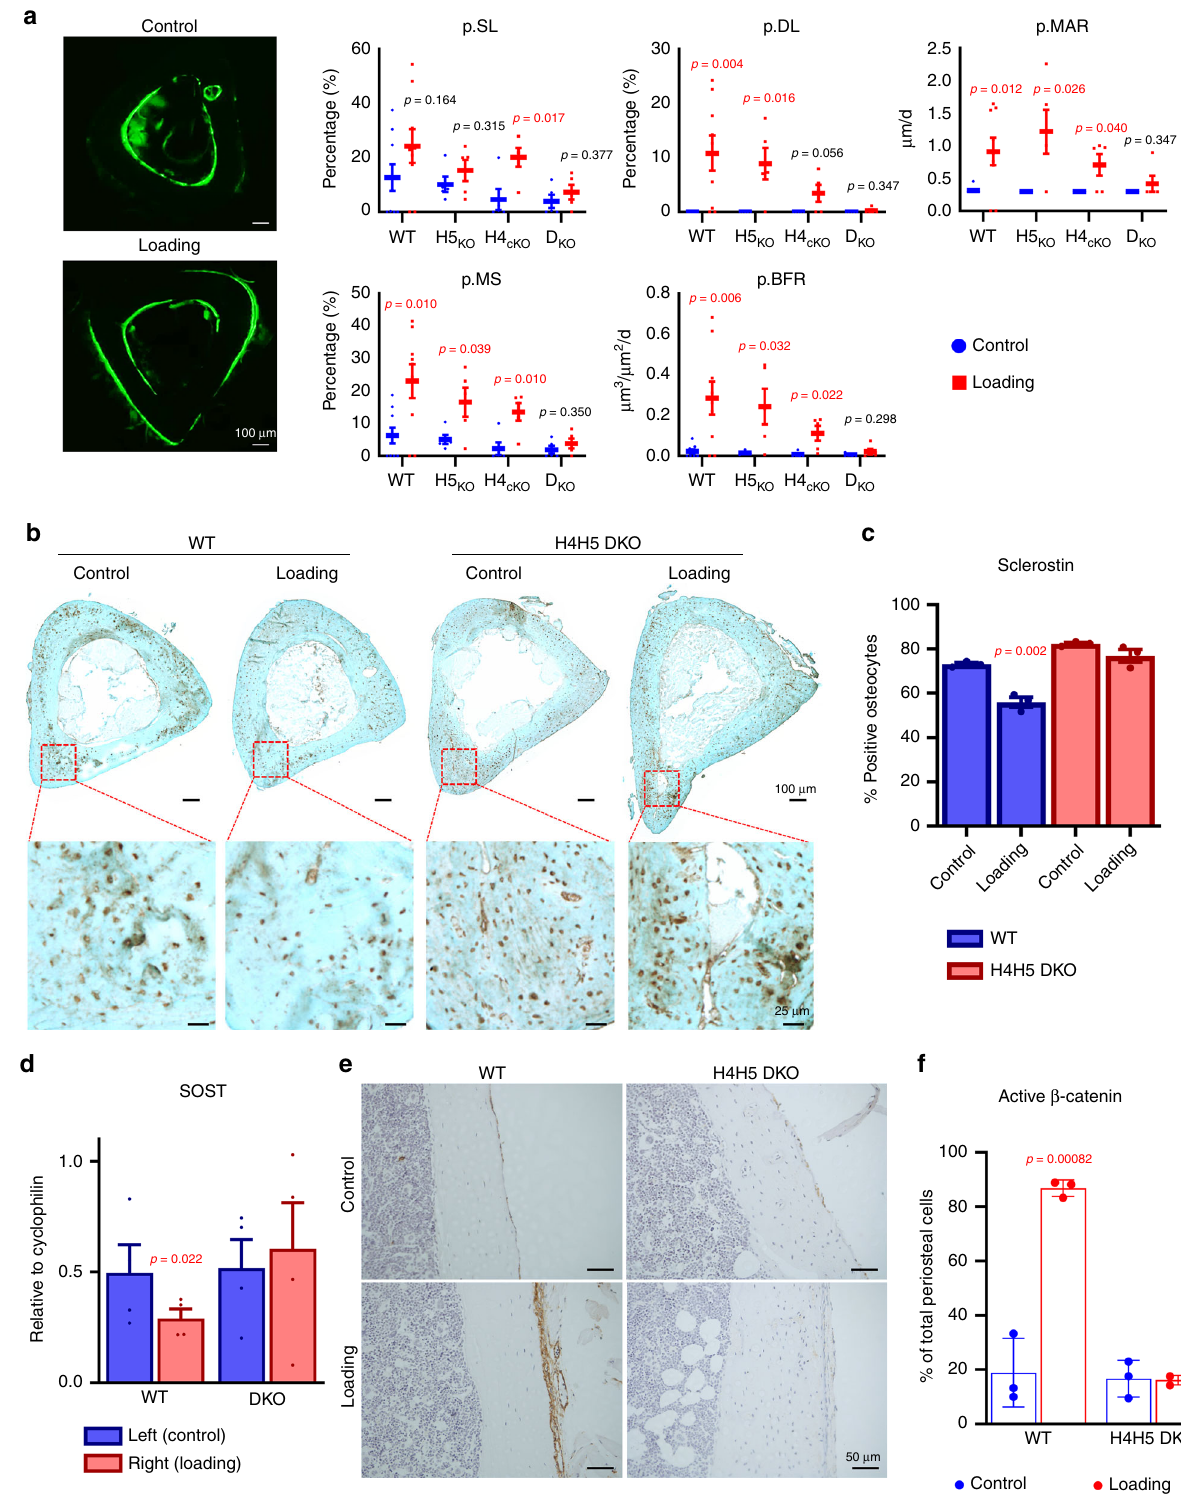
(FFSS) across osteocytic dendritic processes is a major mechan- ism used for mechanotransduction 3 . To complement these in vivo loss of function studies, we exposed control and HDAC4/5-de fi cient Ocy454 cells (a murine mechanosensitive osteocytic cell line 47 ) to FFSS. These experiments reveal two key differences between WT and HDAC4/5-de fi cient cells. First, basal Sost mRNA (in static conditions) is signi fi cantly increased in the